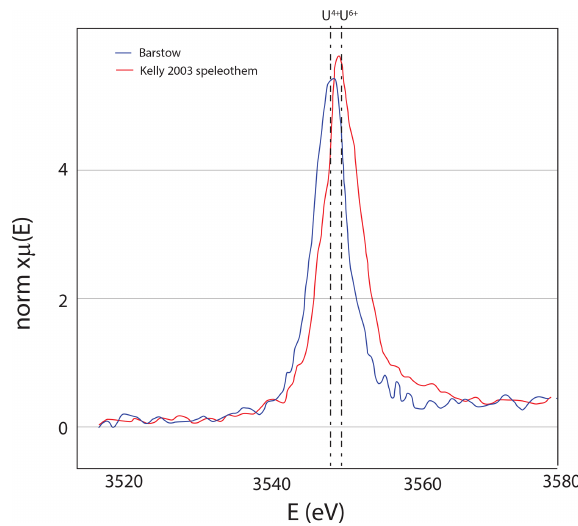
Figure 13. Uranium M 5 edge spectroscopy showing that uranium is in the reduced state; for reference, the U 6 + speleothem of Kelly et al. (2003) is shown as well. Both datasets were measured at the TES beamline as described in Fig. 8.